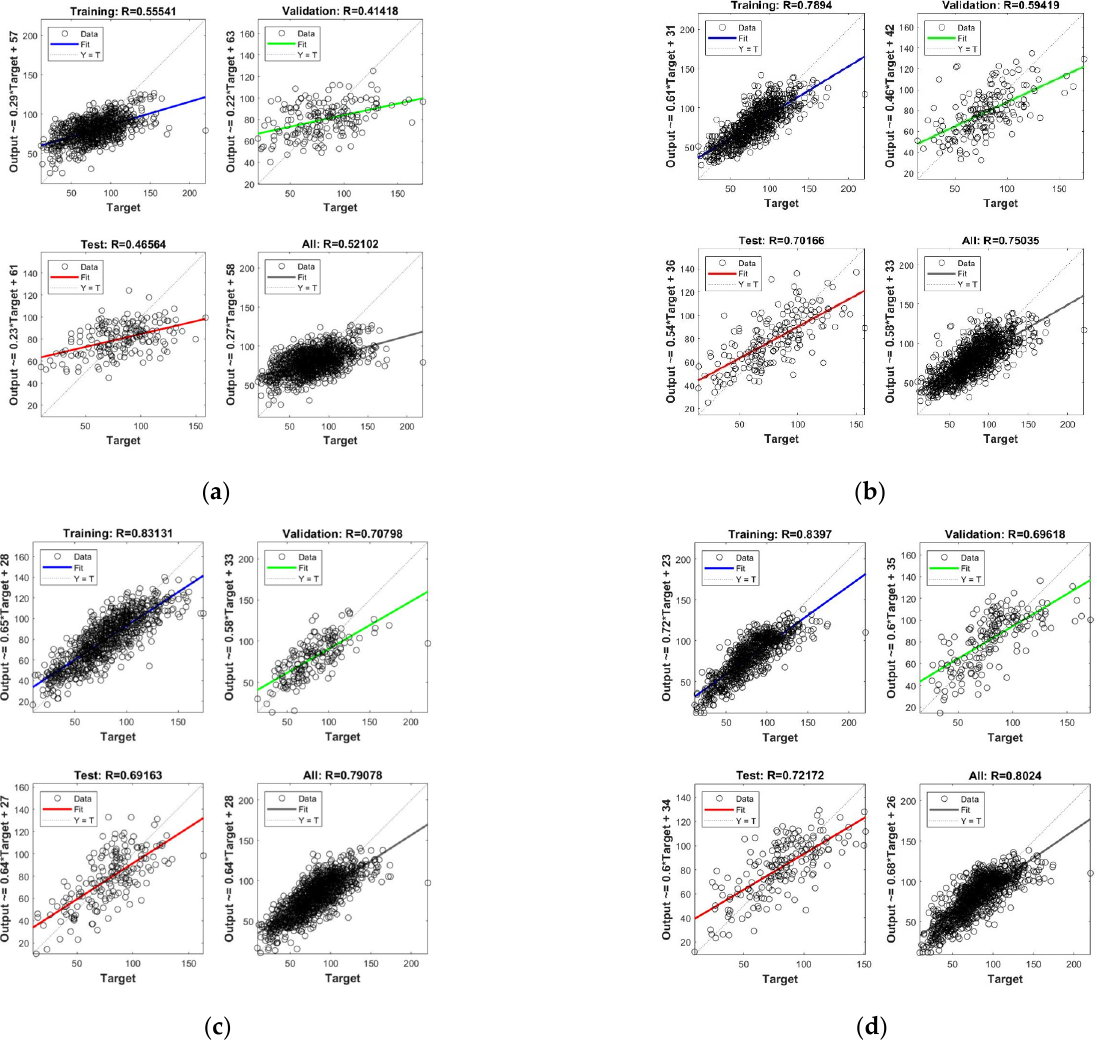
Figure 15. AGB inversion results of different data sources. ( a ) Spectral data only; ( b ) spectral data and seasons; ( c ) combining spectrum, season, grass height; ( d ) combining spectrum, season, grass height, grazing situation.